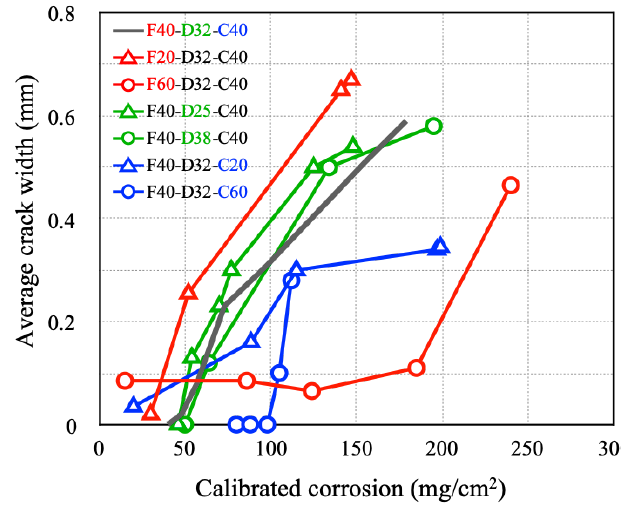
Figure 10. Comparisons of corrosion crack behaviors over transverse bars.